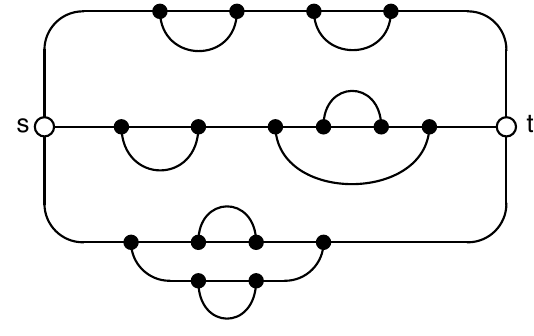
Fig. 9: A cubic series-parallel